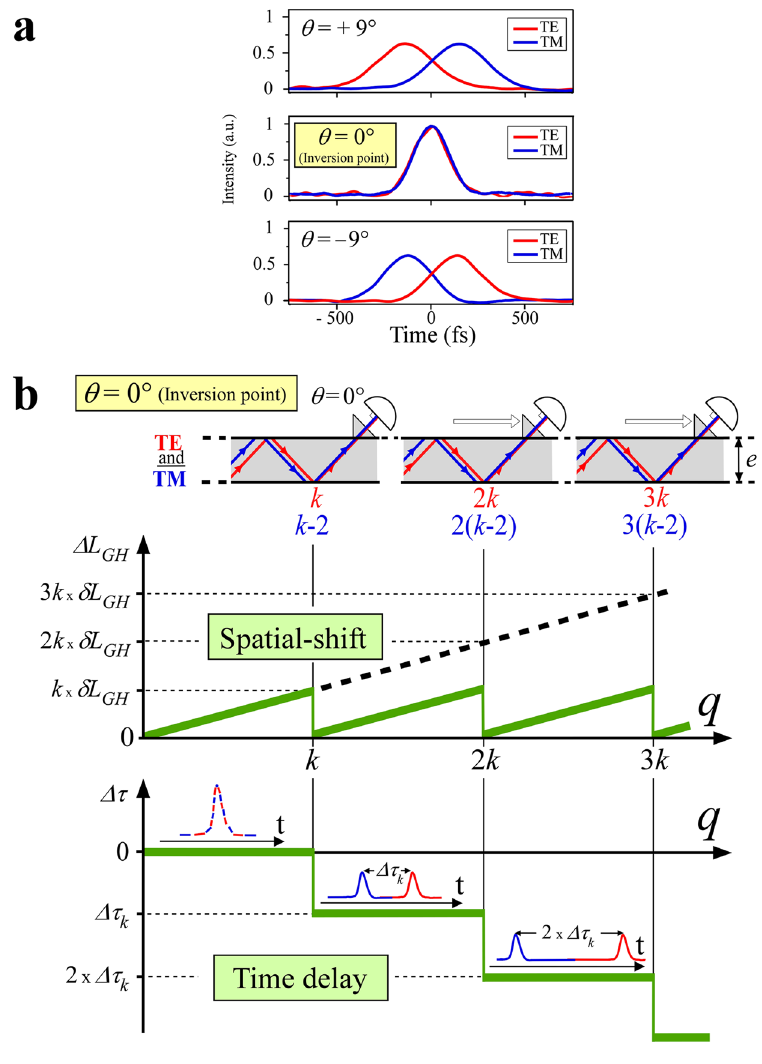
Figure 4. Variability of the measured delay time. (a) Change of sign of the measured delay time between the TE and TM laser pulses around the inversion point, successively observed on the intensity correlation profiles for + 9°, 0° and − 9° rotations of the detection surface of the swivelling two-photon detector. ( b ) After q reflections, for a long waveguide, the TM component catches up with the TE component leading to a cyclical regime for q = k , 2 k , 3 k . If the laser pulse polarization is launched at 45° from the incidence plane of the prism, for q varying from 1 to k , with the detector oriented at θ = 0°, the Newton-Wigner delay between TM and TE is automatically compensated (see text). By contrast, for q = k , as the spatial shift Δ L GH is cancelled, the detector receives two pulses separated by a Δτ k delay including the Newton-Wigner delay (see Supplementary Information). For q = 2 k and 3 k the delay Δτ at θ = 0° is multiplied by 2 and 3